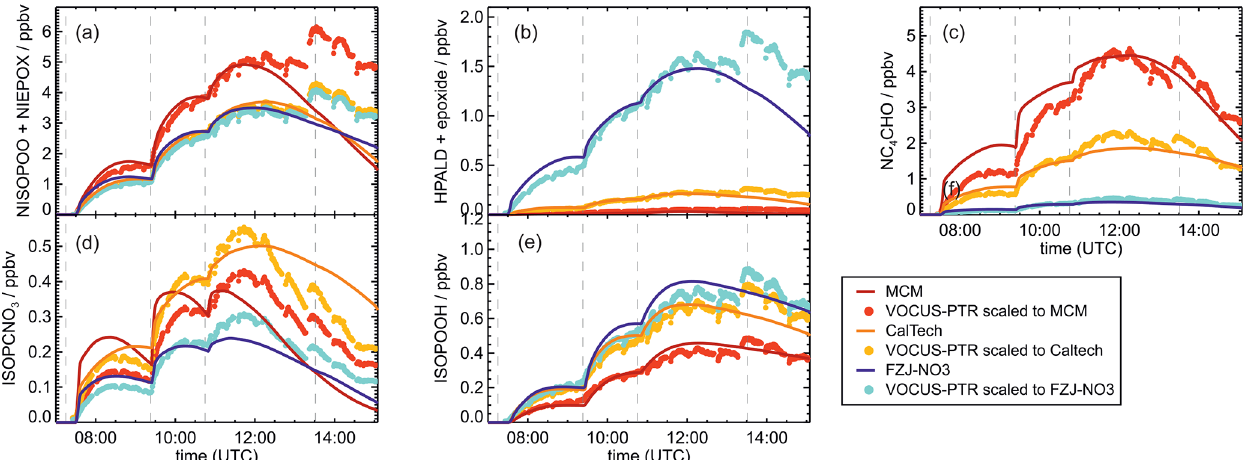
Figure A11. Ion mass signal of the Vocus PTR-MS instrument scaled to the model results from the MCM, Caltech and FZJ-NO3 models in the experiment on 13 August 2018 (Experiment 4). Only species for which the instrument was not calibrated and which are produced in all models are